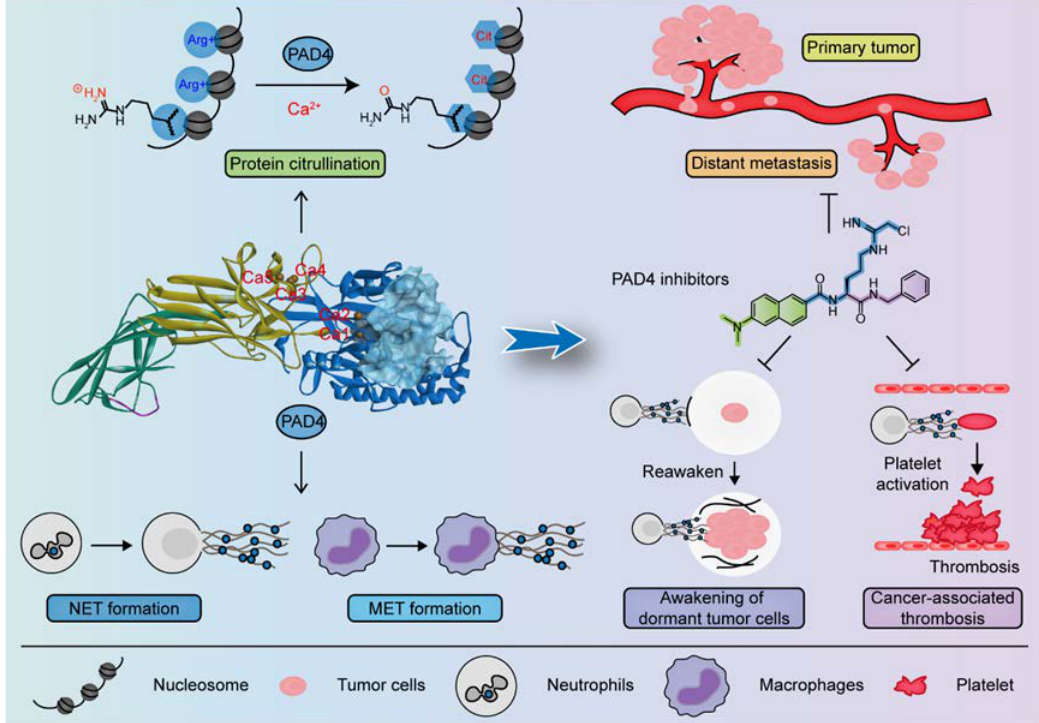
Figure 1. PAD4 and its inhibitors in cancer progression and prognosis. PAD4 promoted citrullination and NET formation in a calcium-dependent manner to induce tumor growth, metastasis, cancer cells awakening and cancer-associated thrombosis, which could be blocked by PAD4 inhibitors.